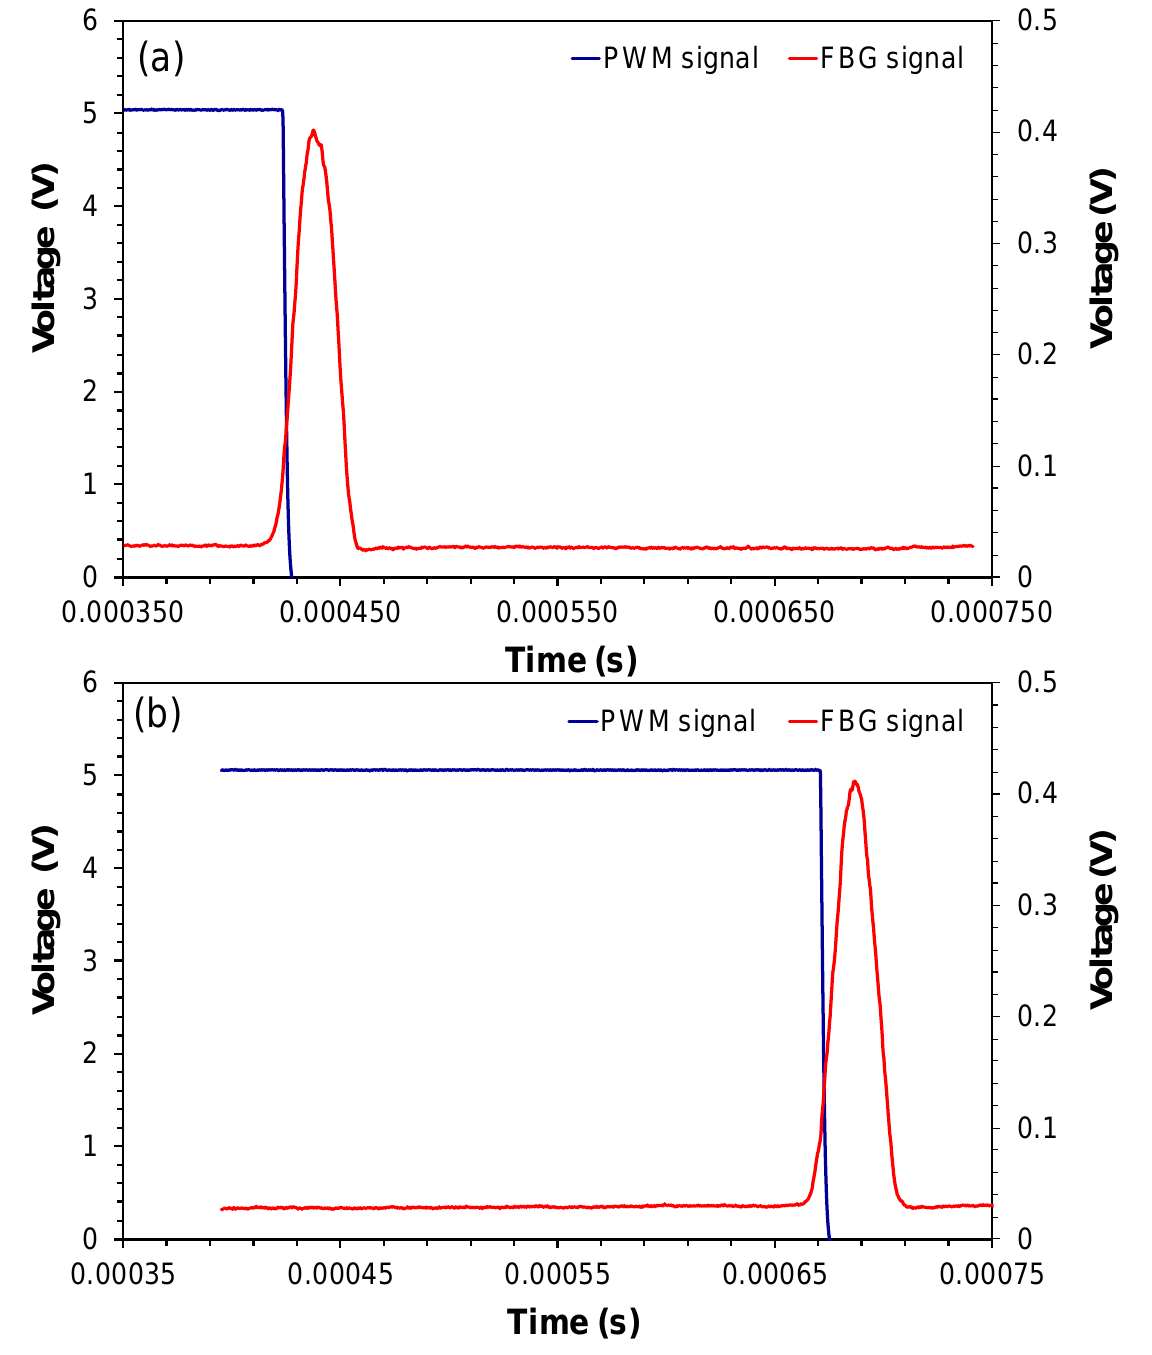
Figure 4. ( a ) and ( b ) Signal in C and D respectively for FBG position in minimum and maximum PZT strain.